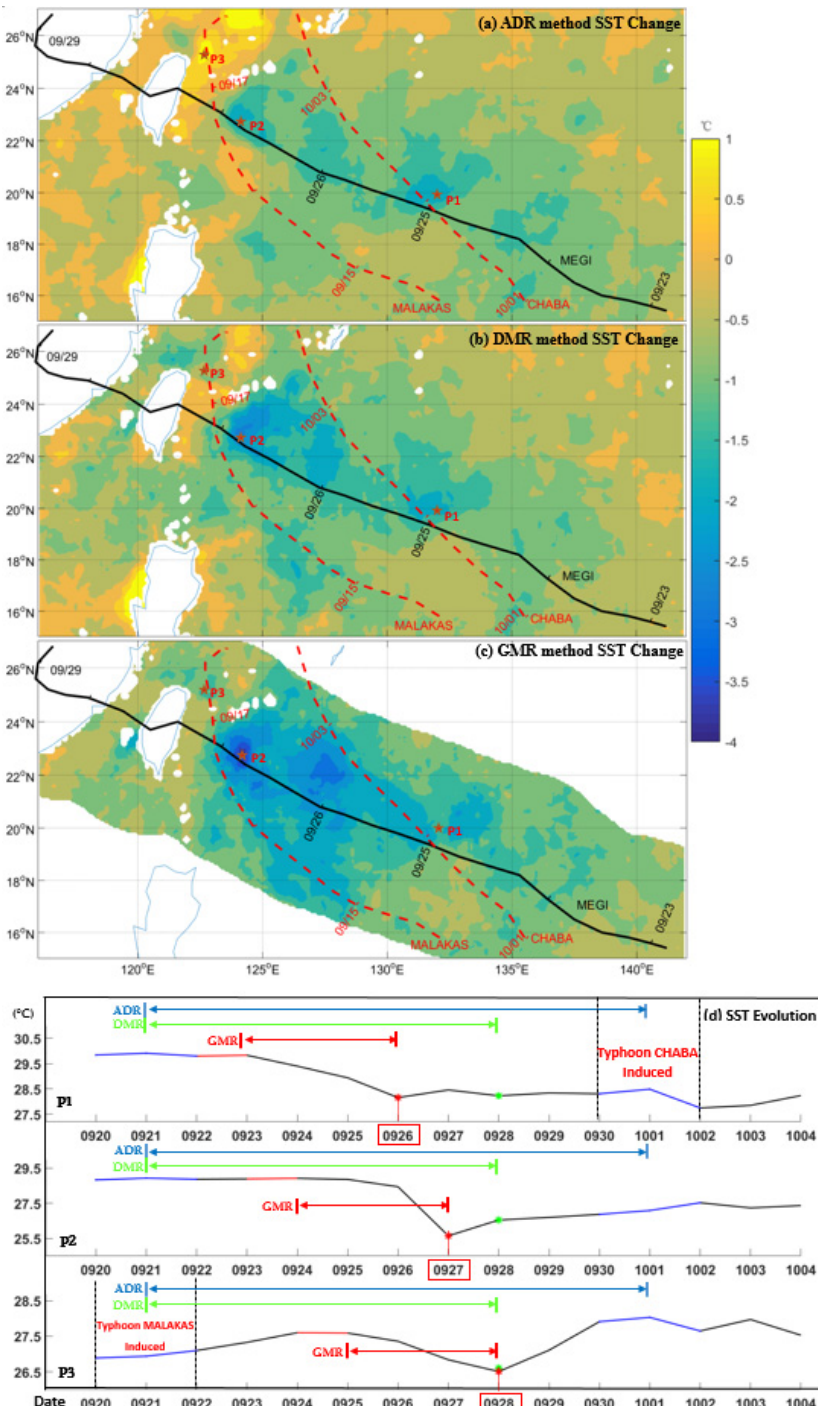
Figure 4. ( a – c ) SST response field during the passage of Typhoon Megi (2016) evaluated by the ADR, DMR and GMR methods. ( d ) Evolution of the SST at three different points corresponding to P1, P2 and P3 in parts ( a – c ). The fixed blue and green temporal segments represent the SST response time (from pre- to post-Megi) in the ADR and DMR methods, respectively. The red segments represent the responding and background SSTs in the GMR